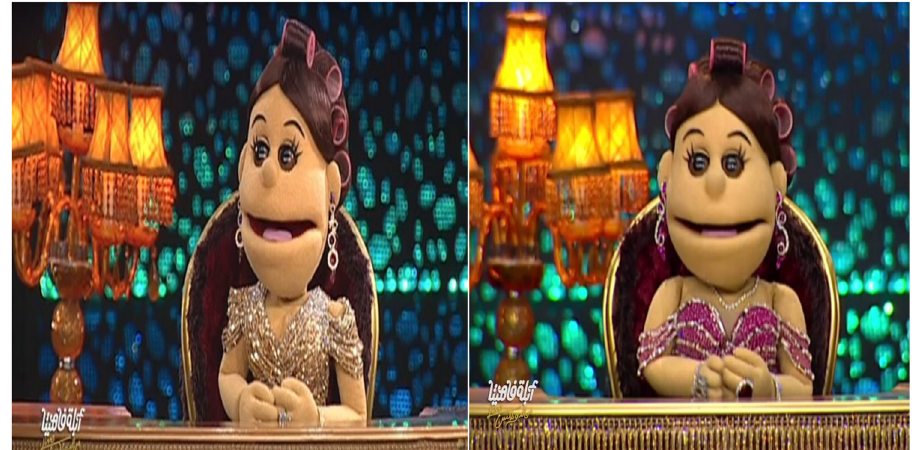
Figure 1: Abla Fahita at the